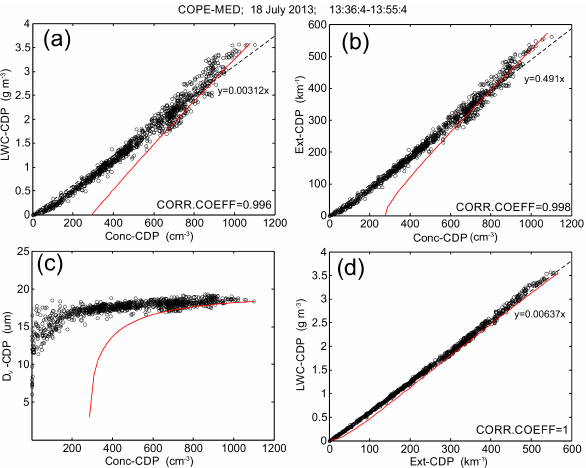
Figure 14. Relationships between (a) LWC( N) ; (b) β(N) ; (c) D v (N) ; (d) LWC( β) calculated from the CDP measurements obtained during sampling several convective clouds. The mea- surements were conducted during the COPE-MED project on 18 July 2015, H = 5500m, T = − 12 ◦ C, RH = 0.2. The measure- ments were sampled at 10Hz ( ∼ 10m spatial resolution). Dashed lines are linear regressions. Red lines indicate primary inhomoge- neous mixing dependencies calculated for the same environmental